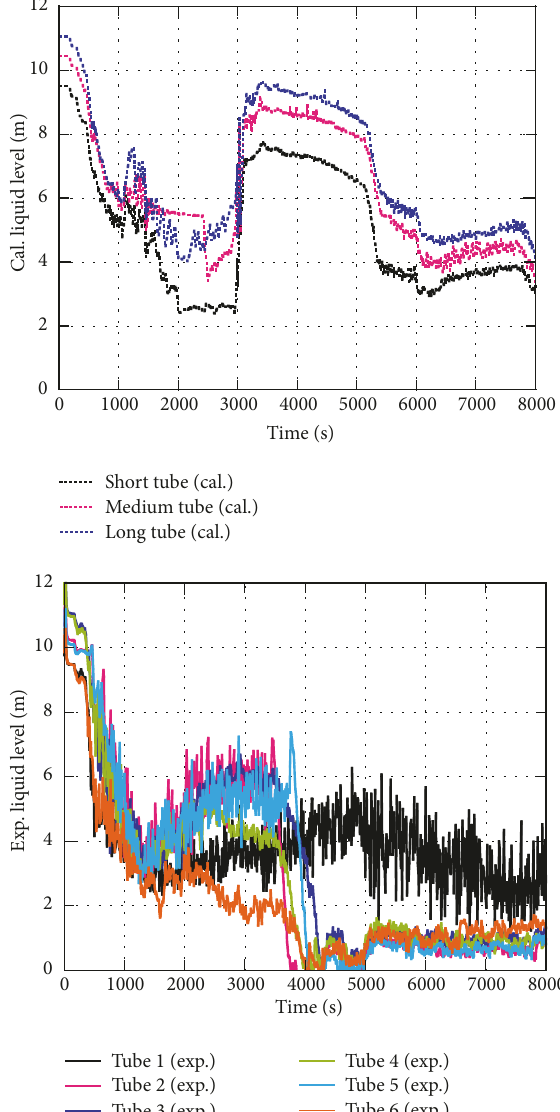
Figure 8: TR-LF-18 test and RELAP5 results for SG U-tube upflow- side collapsed liquid level in loop